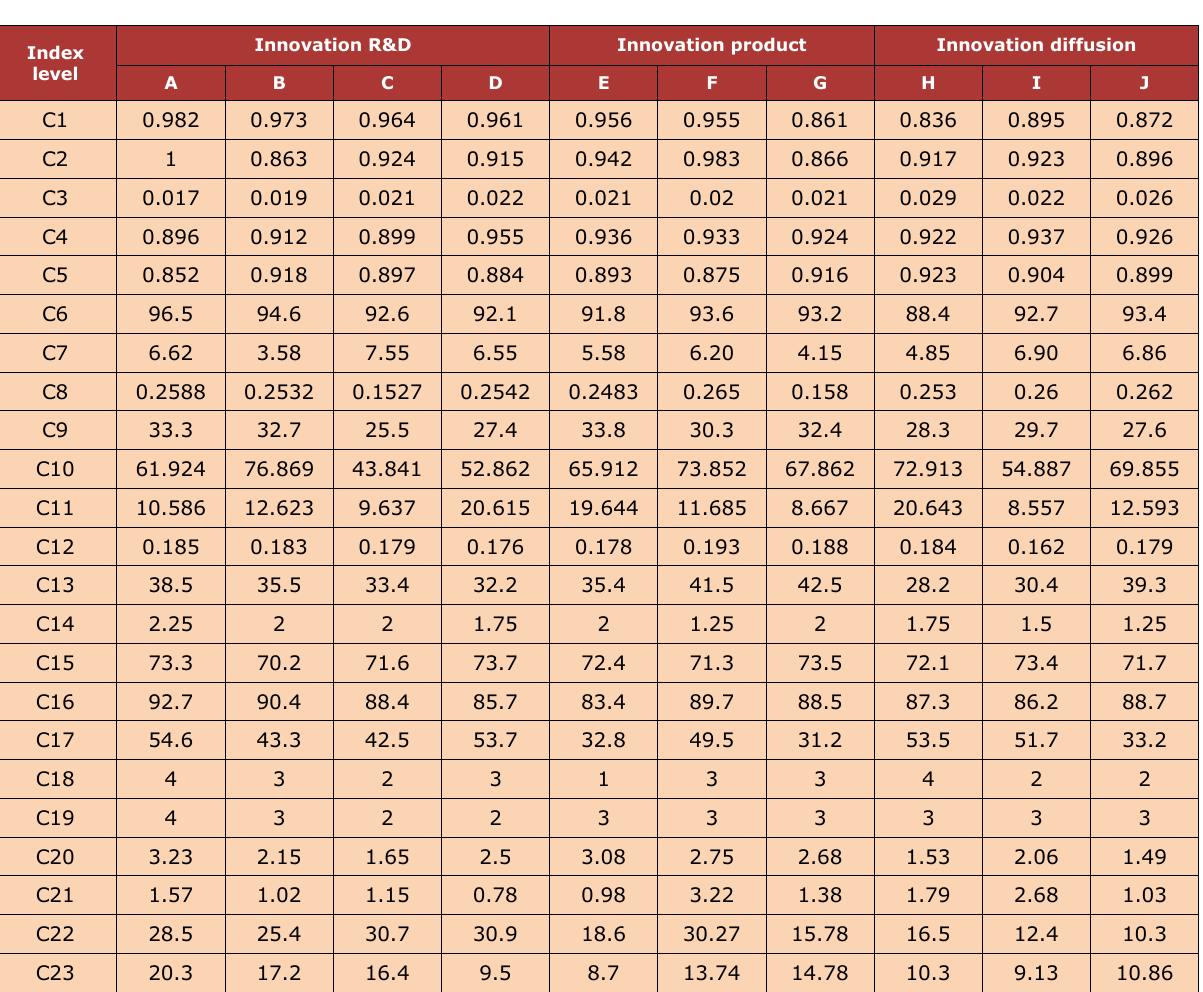
Table 5. Original Data of Suppliers in Innovation Chain-oriented Public